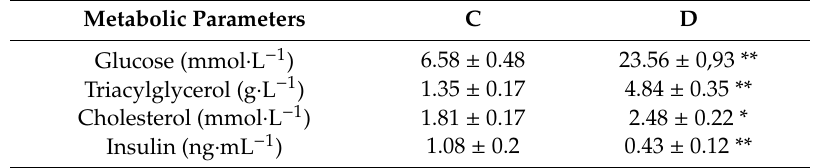
Table 1. Metabolic state of the control and streptozotocin-induced diabetic experimental rats. Metabolic